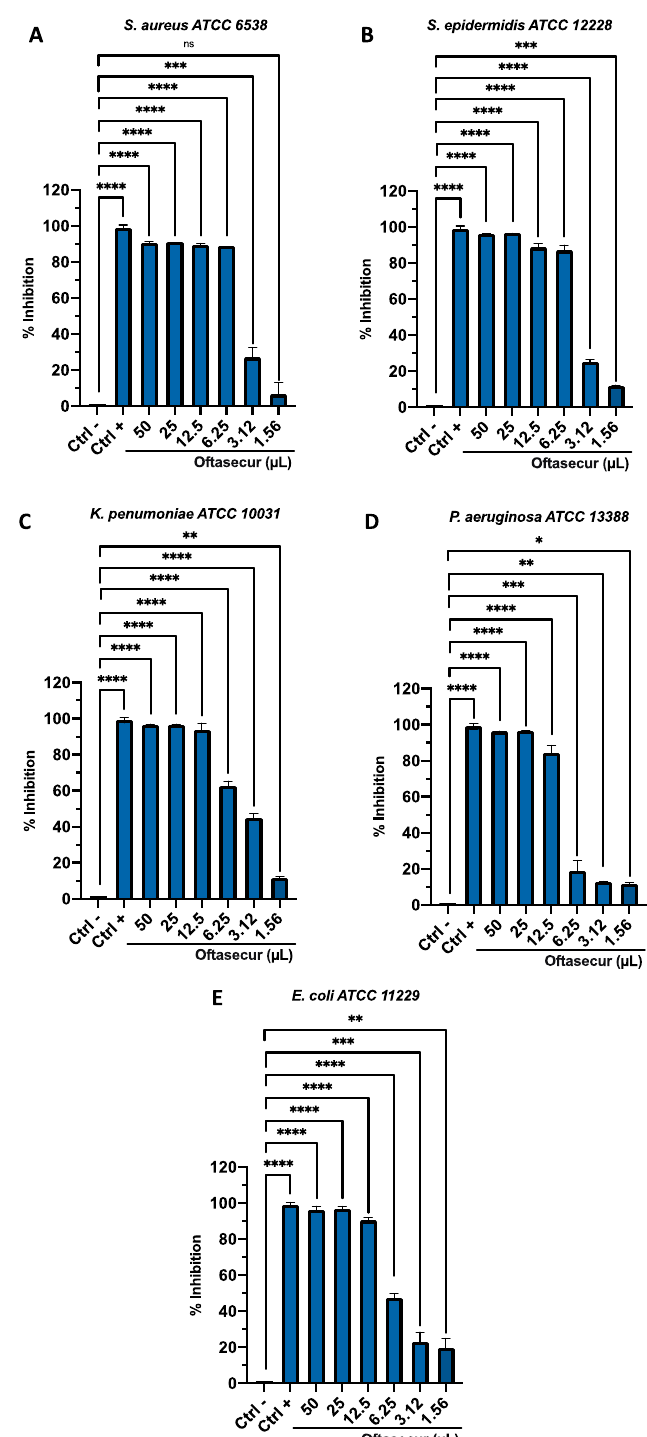
Figure 3. Antimicrobial activity of Oftasecur against ( A ) S. aureus (****: p -value < 0.0001, ***: p -value < 0.0014, ns: p -value > 0.71); ( B ) S. epidermidis (****: p -value < 0.0001, ***: p -value = 0.0009); ( C ) K. pneumoniae (****: p -value < 0.0001, **: p -value = 0.0012) ; ( D ) P. aeruginosa (****: p -value < 0.0001, ***: p -value = 0.0008, **: p -value = 0.0016, *: p -value = 0.023) ; ( E ) E. coli (****: p -value < 0.0001, ***: p -value = 0.0006, **: p -value = 0.0019) .